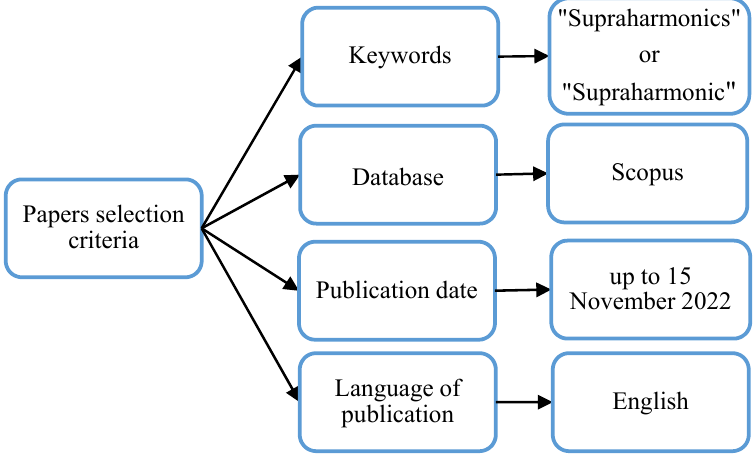
Figure 1. Methodology for materials selection.